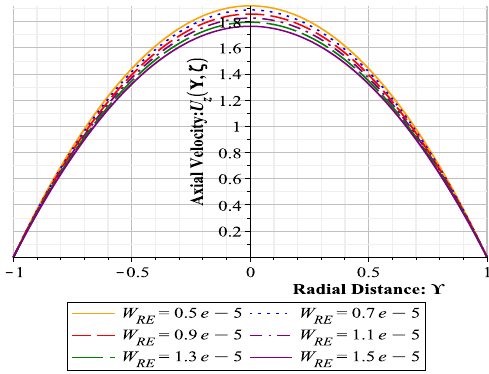
Figure 1. Behavior of U z ( γ , ζ ) with γ at ζ = 0.1 for different values of W RE .